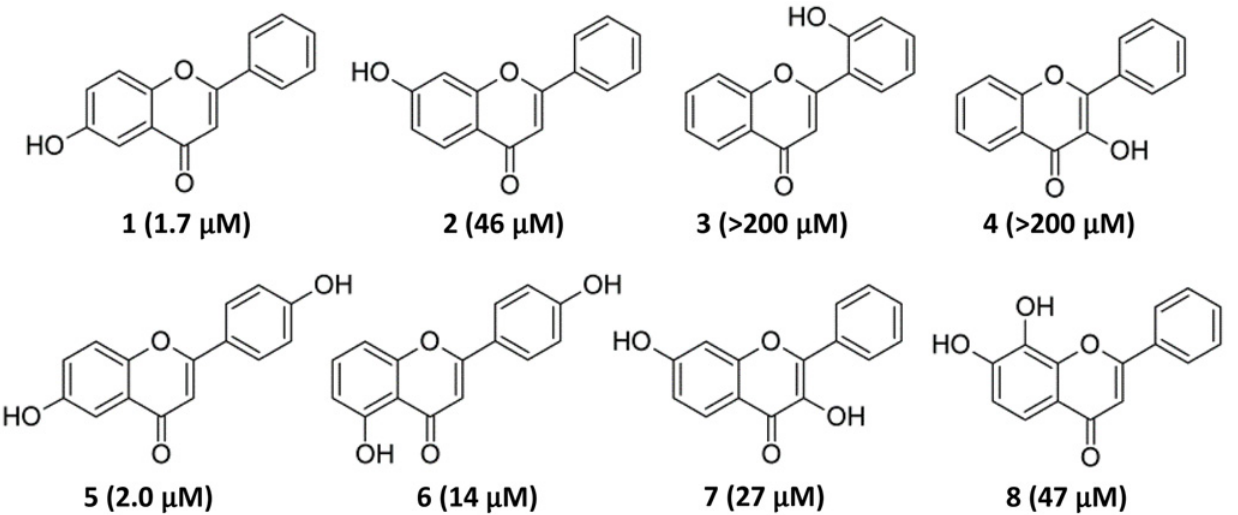
Fig 2. Structures of monohydroxylated and dihydroxylated flavones with IC 50 against LPS-induced NO